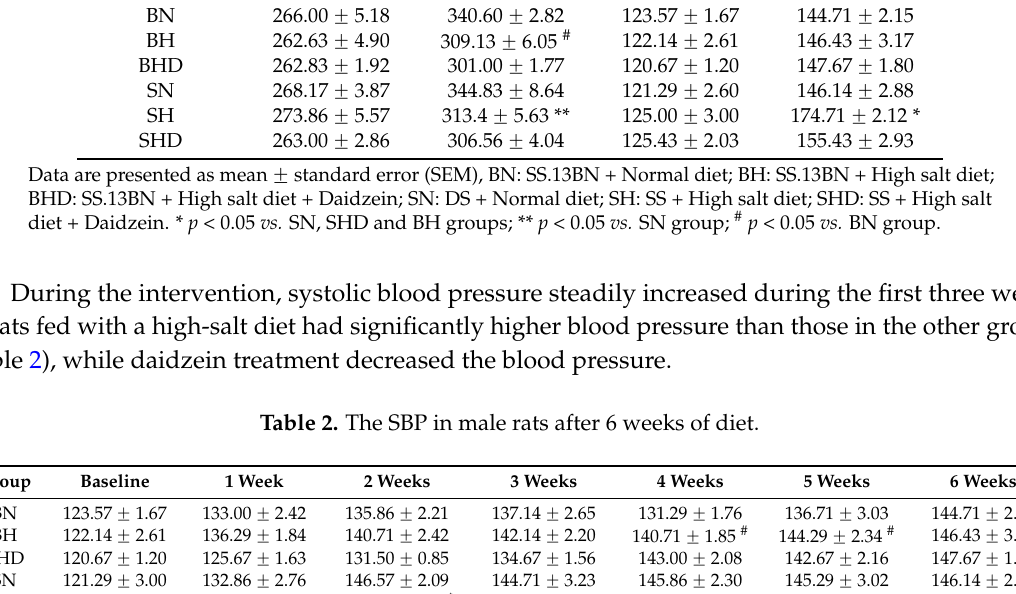
Table 1. Effect of intervention on weight and systolic blood pressure (SBP, n = 8). Weight (g) Group